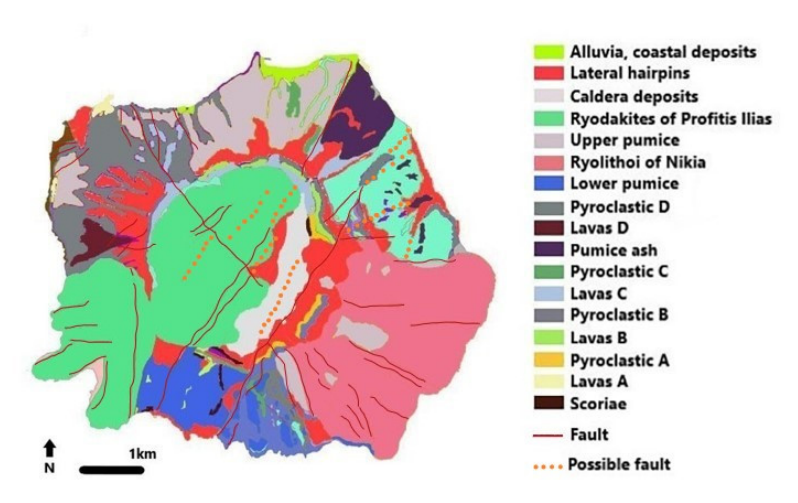
Figure 3. Geological map of Nisyros [44], modified.